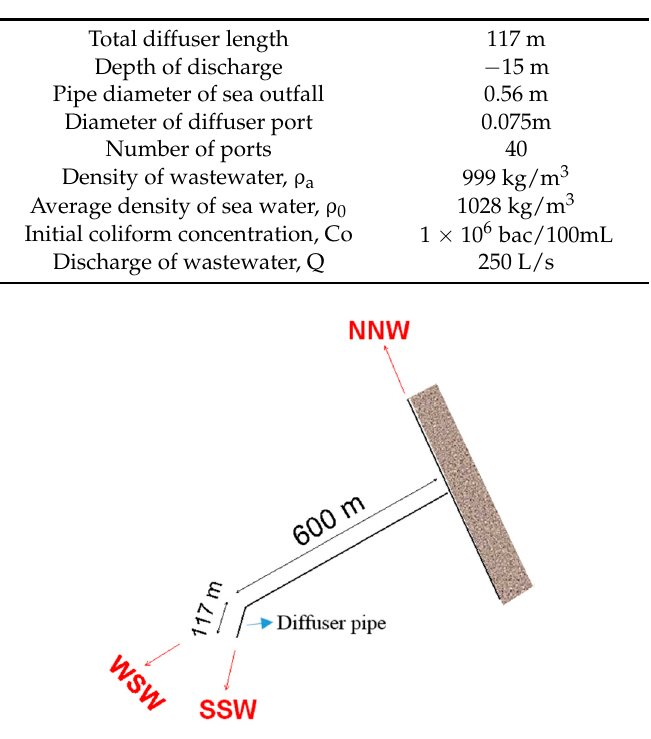
Table 3. Physical properties of Edremit–Zeytinli sea outfall.